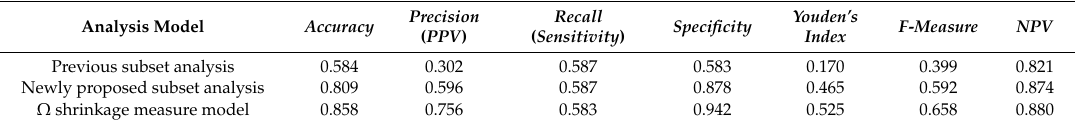
Table 4. Evaluation of detected drug–drug interaction signals.